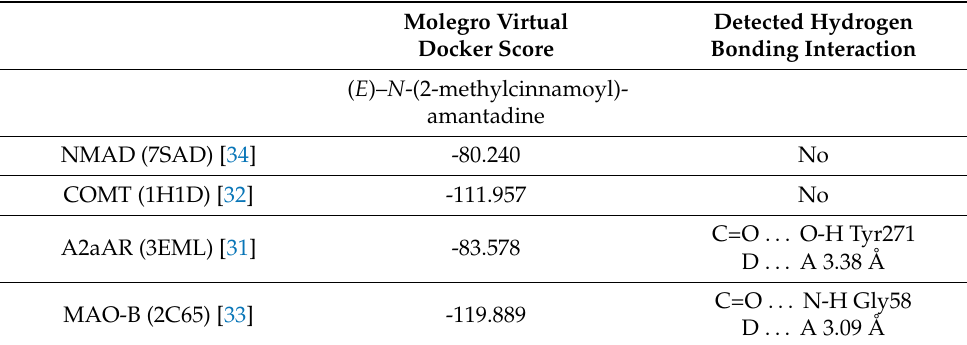
Table 2. Molecular docking score (kcal/mol) of ( E )– N -(2-methylcinnamoyl)-amantadine against selected targets associated with